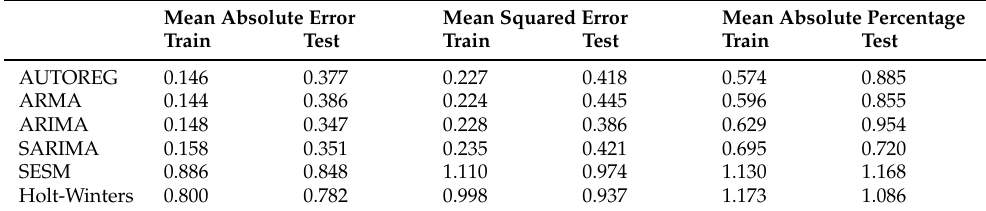
Table 9. Error measures obtained under the six time series models.